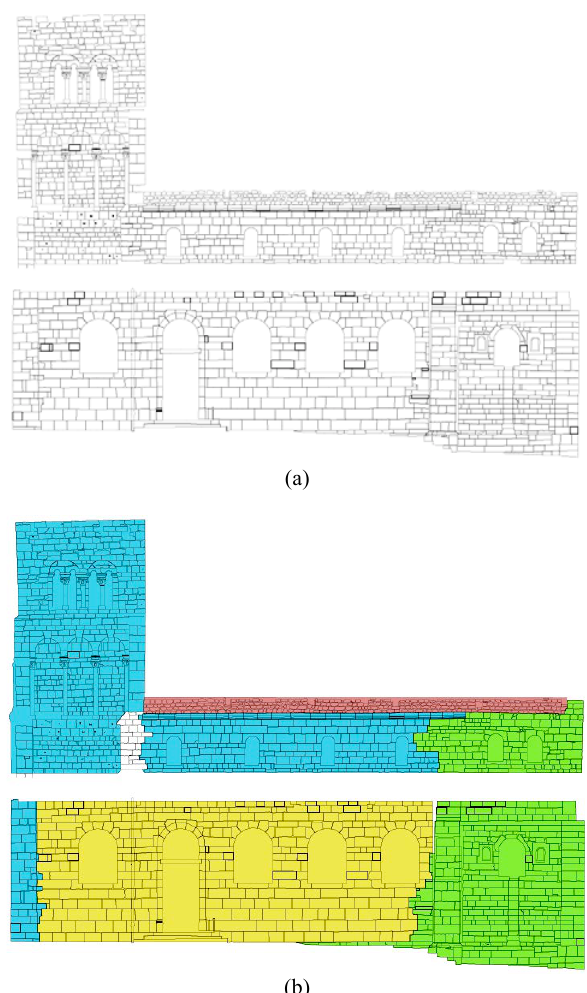
Figure 8. Photogrammetric plots: (a) stone by stone survey; (b) phasing: blue: Romanesque period; green: late Middle-Ages – Renaissance; pink: XVII th century; yellow: XVIII th -XIX th